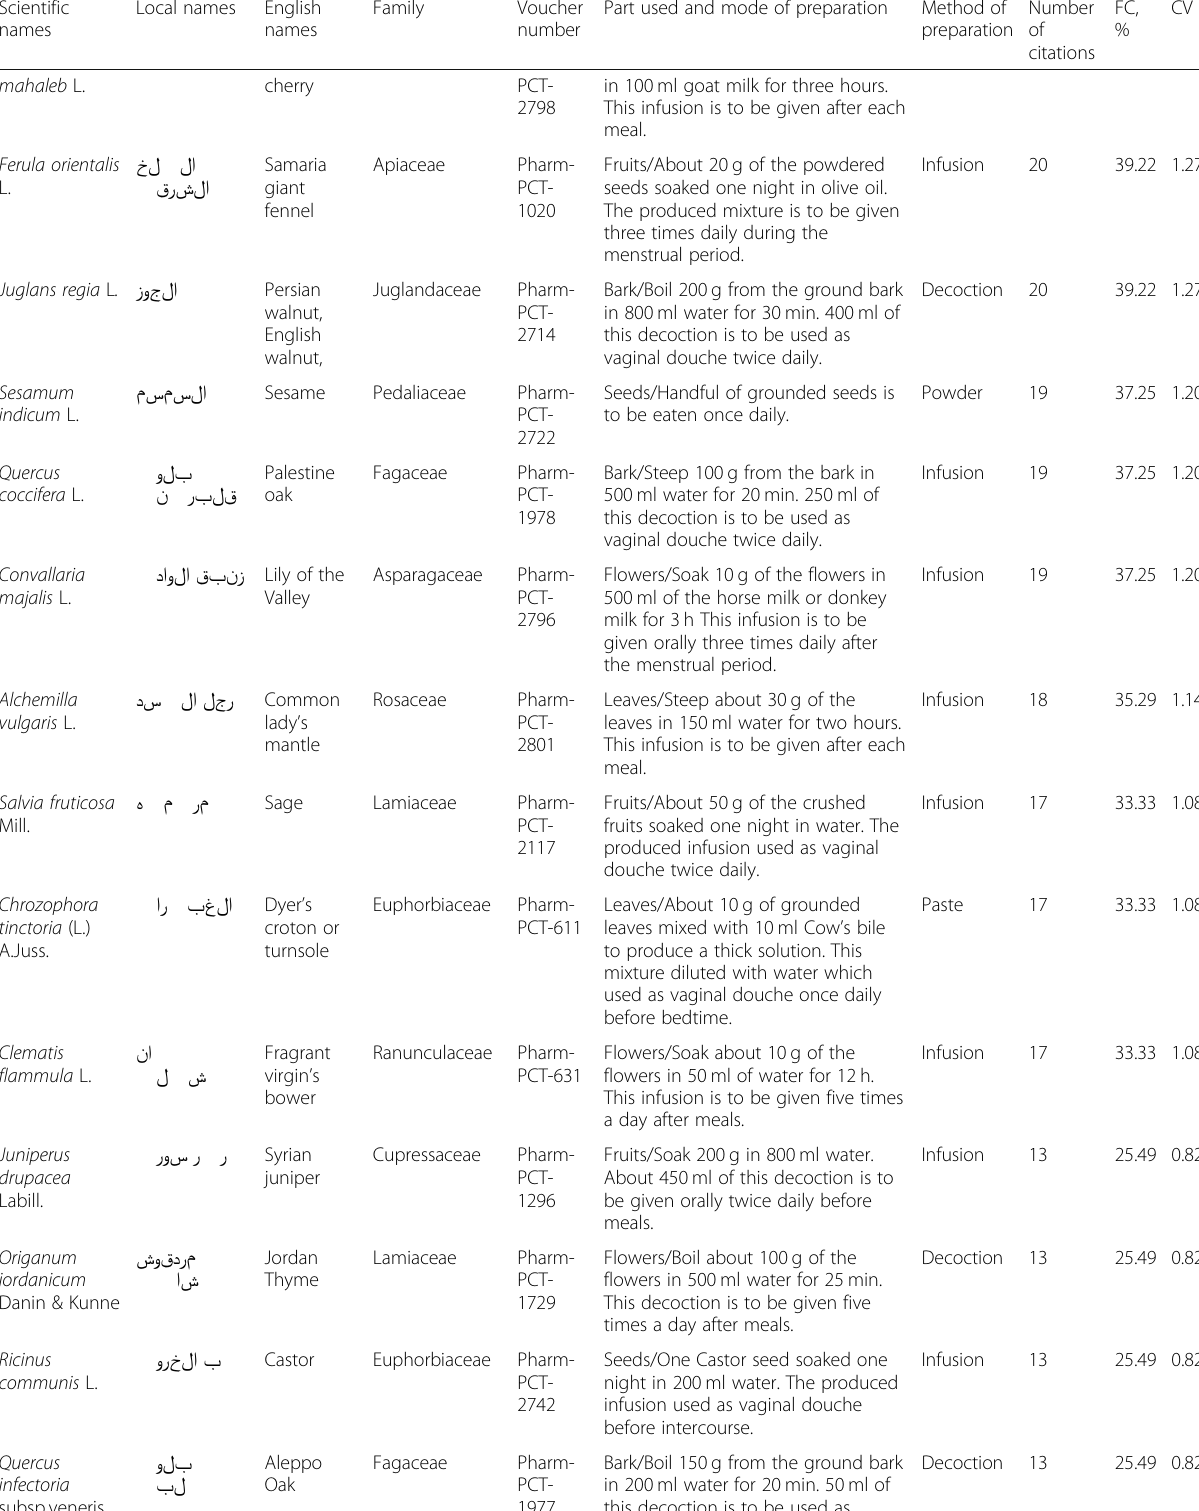
Table 2 The used herbals for the treatment of infertility in females, the plant ’ s parts used, Frequency of Citation (FC), Choice values, modes of administration and methods of preparation